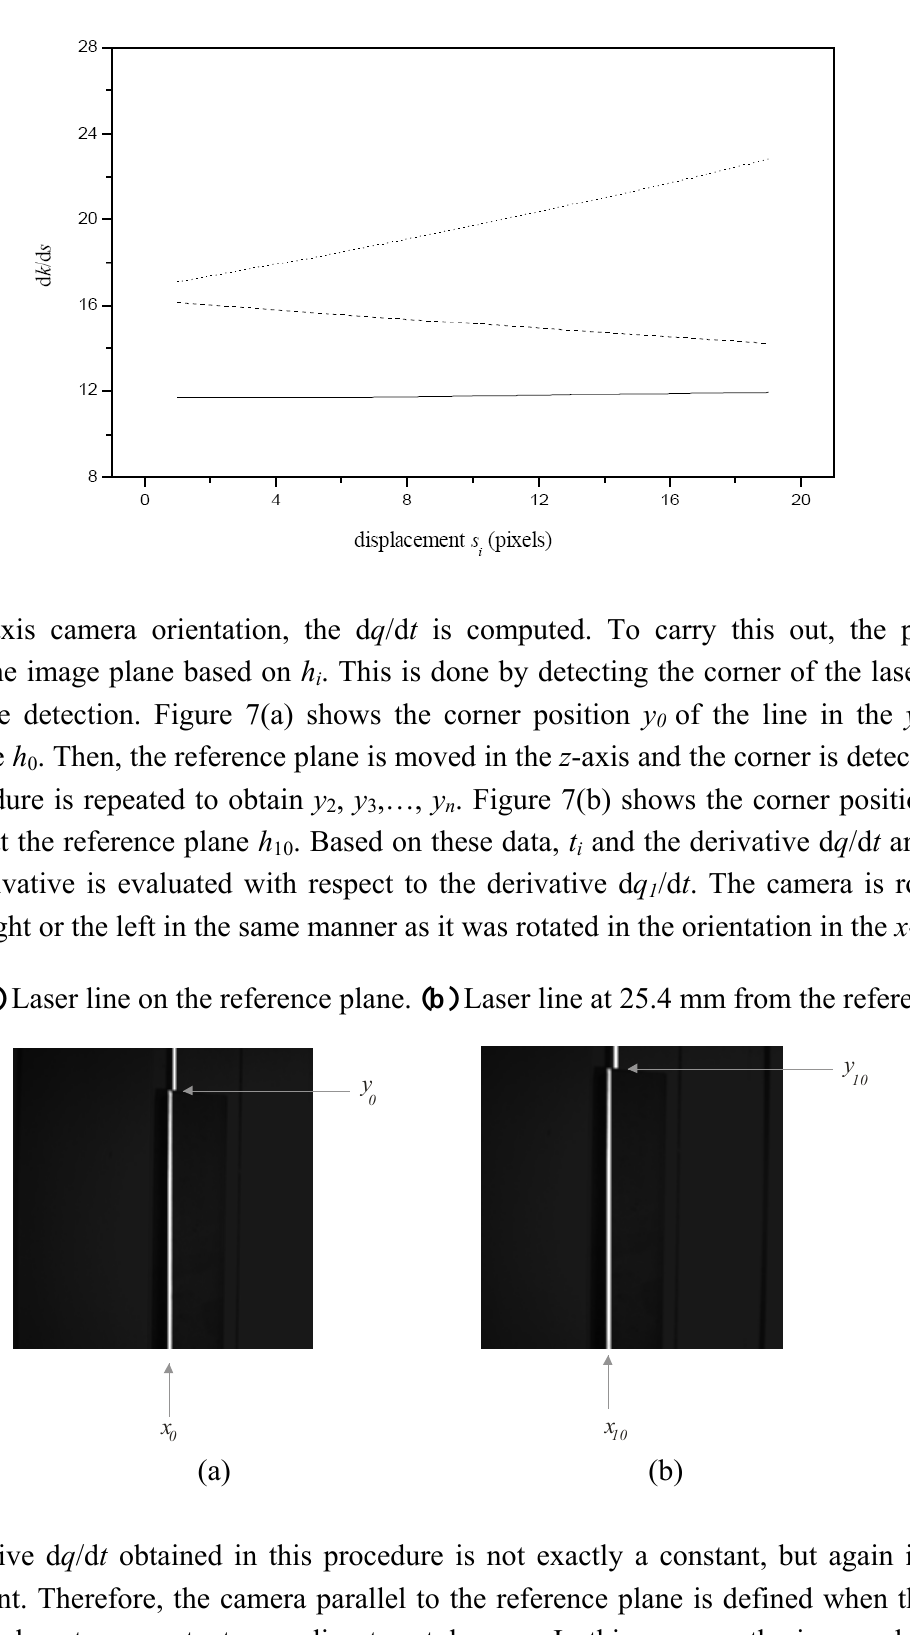
Figure 6. Derivative d k /d s for an optical axis perpendicular and not perpendicular to the x